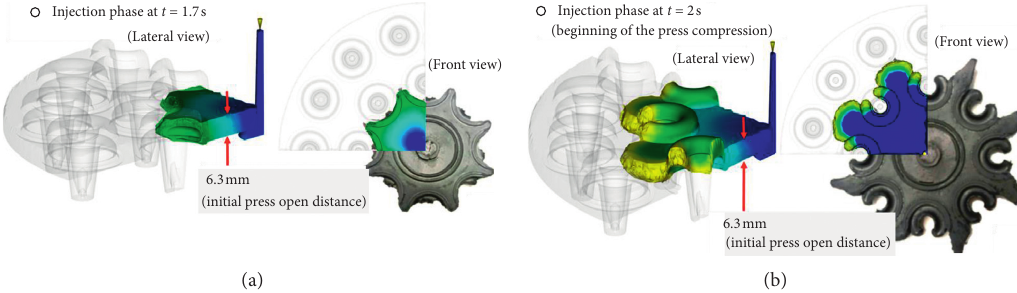
Figure 7: Results of the filling patterns obtained from simulation (Fill Time) and the corresponding incomplete molded part obtained through interrupted filling experiments at 1.7s (a) and 2s (b) of Fill Time. In both cases, the initial press open distance is 6.3mm.